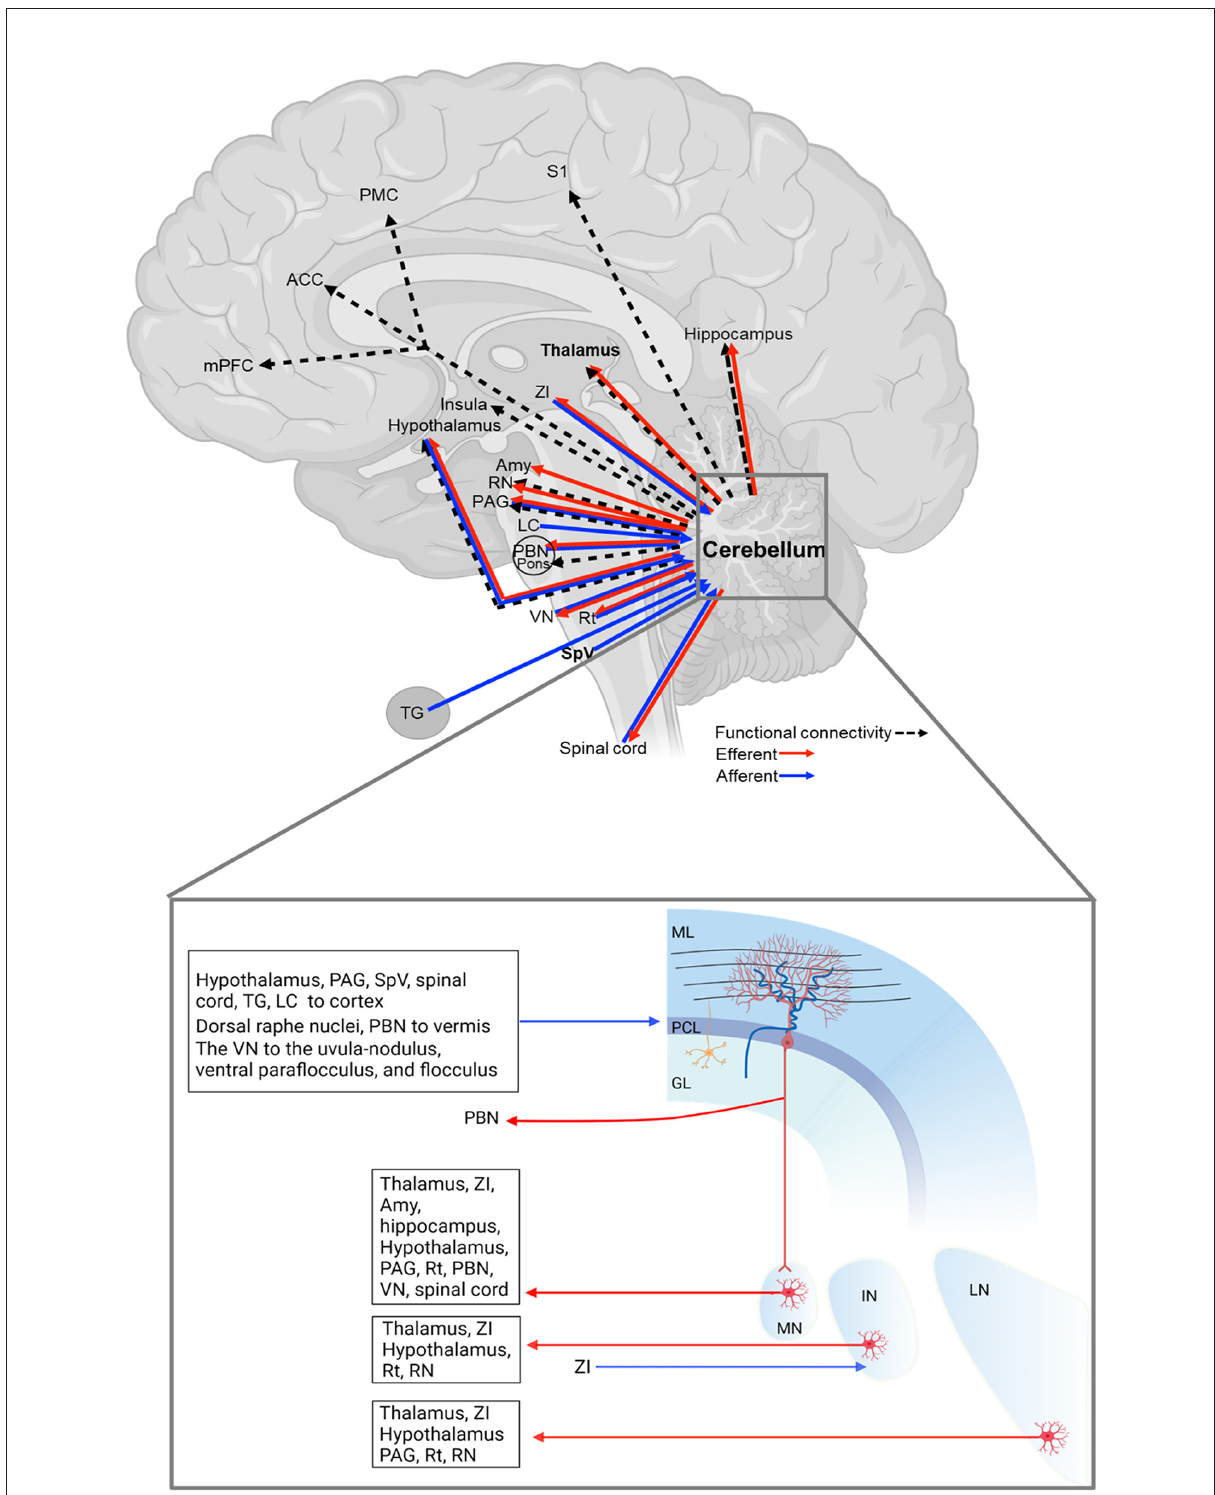
FIGURE1 Cerebellar connections with pain/migraine-relevant brain regions. The details of each connection are in Table 1 . GL, granular cell layer; IN, interposed cerebellar nucleus; LN, lateral cerebellar nucleus; ML, molecular layer; MN, medial cerebellar nucleus; PCL, Purkinje cell layer. The figure was created with